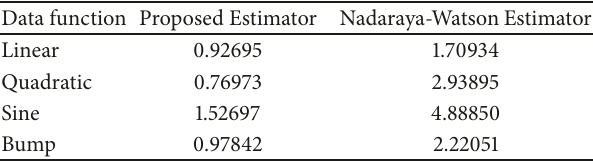
Table 4: Summary results of 95 % confidence interval